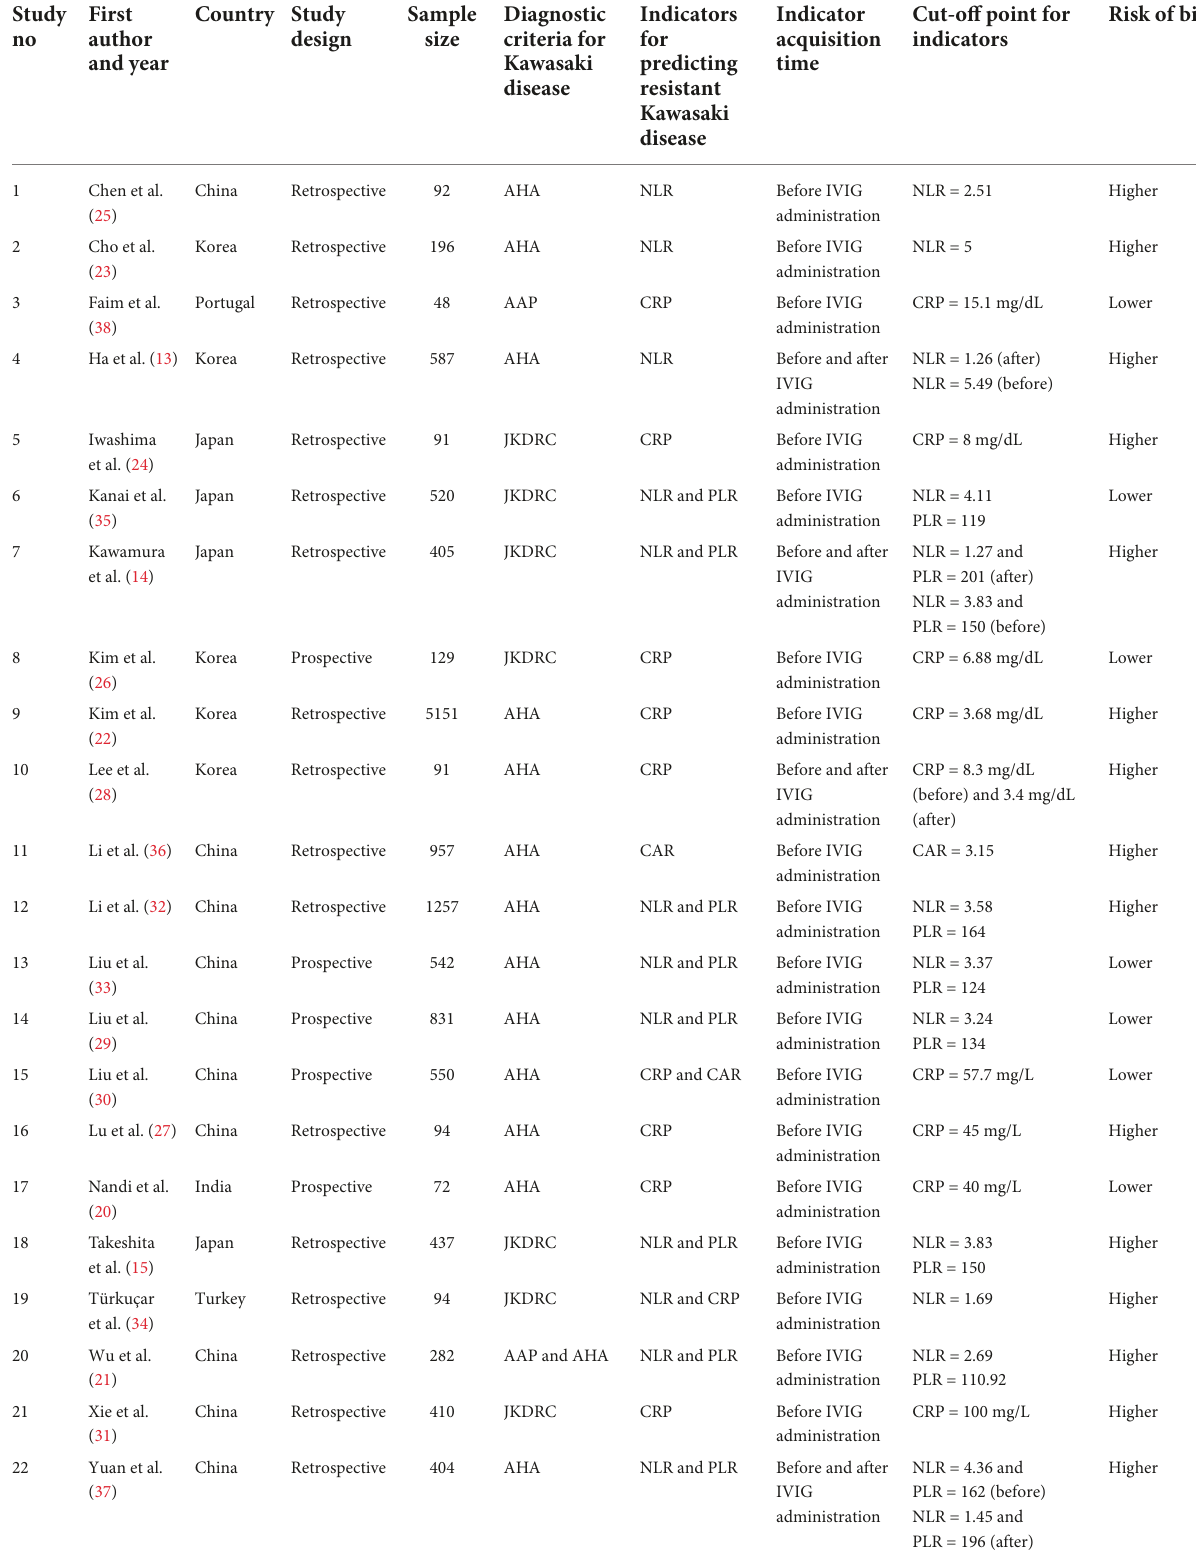
TABLE 1 Characteristics of the included studies ( N =